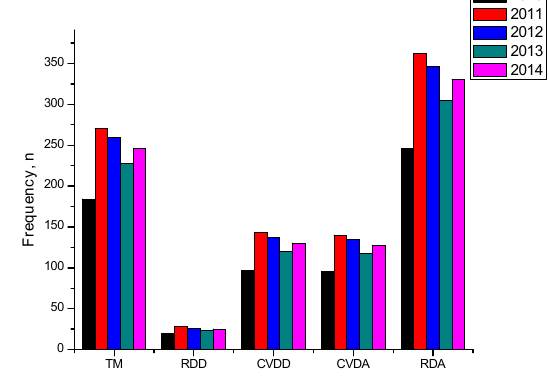
Fig. 2. Health endpoints because of PM 10 exposure and annual number of cases (TM: Total mortality; RDD: Respiratory disease death; CVDD: Cardiovascular disease death; CVDA: Cardiovascular disease admission; RDA: Respiratory disease admission)